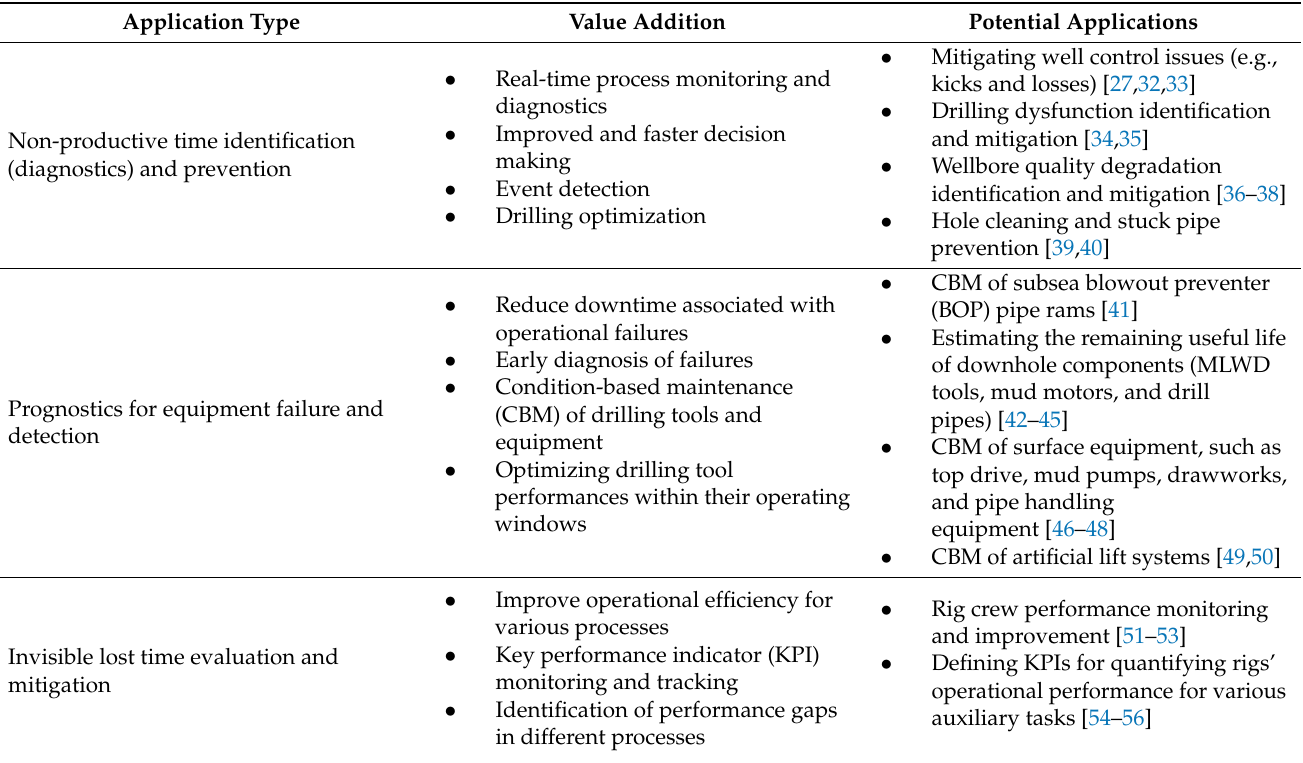
Table 1. Current applications for improving operational efficiency and safety and in well